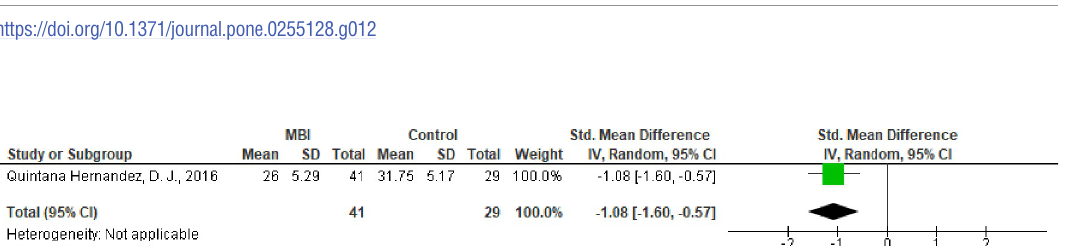
Fig 12. Forest plot of comparison: Mindfulness, MBI versus control after 11 weeks to 6 months from the beginning of the intervention.